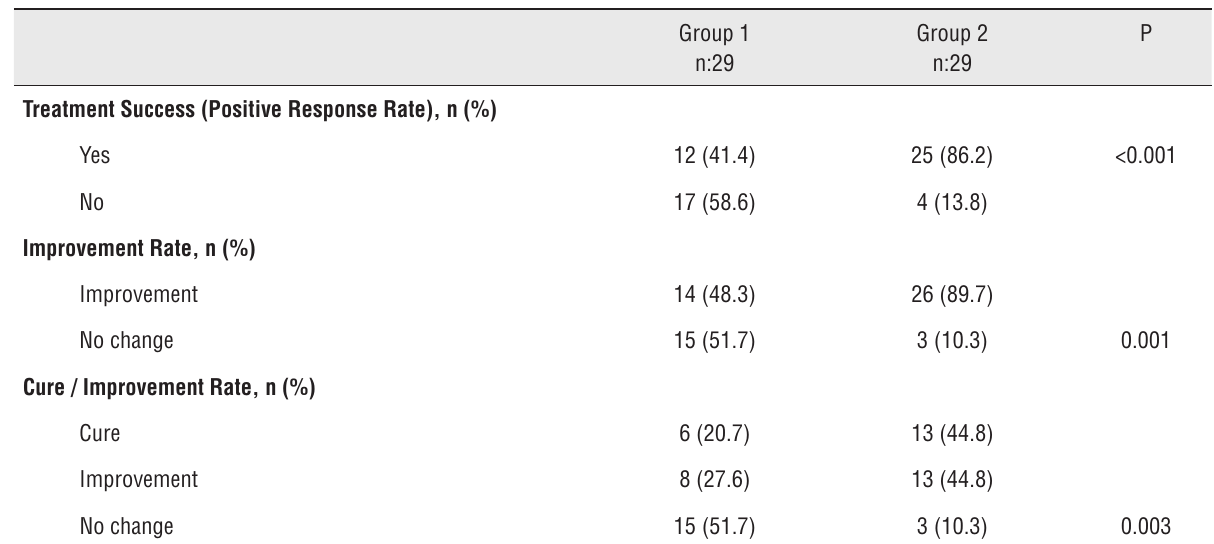
Table 3 - Intergroup comparison according to cure/improvement and positive response rates.